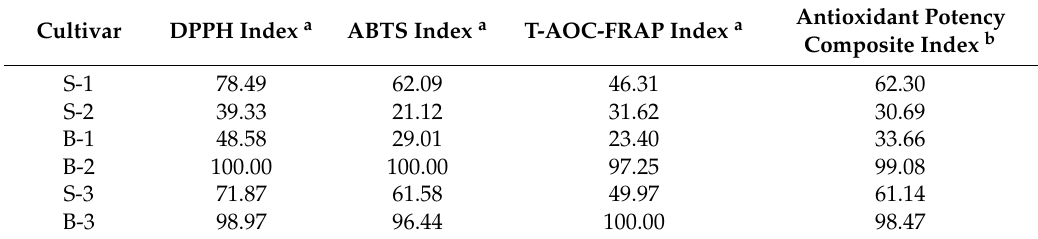
Table 3. Antioxidant potency composite index of flavonoids compounds in six red lettuces. Cultivar DPPH Index